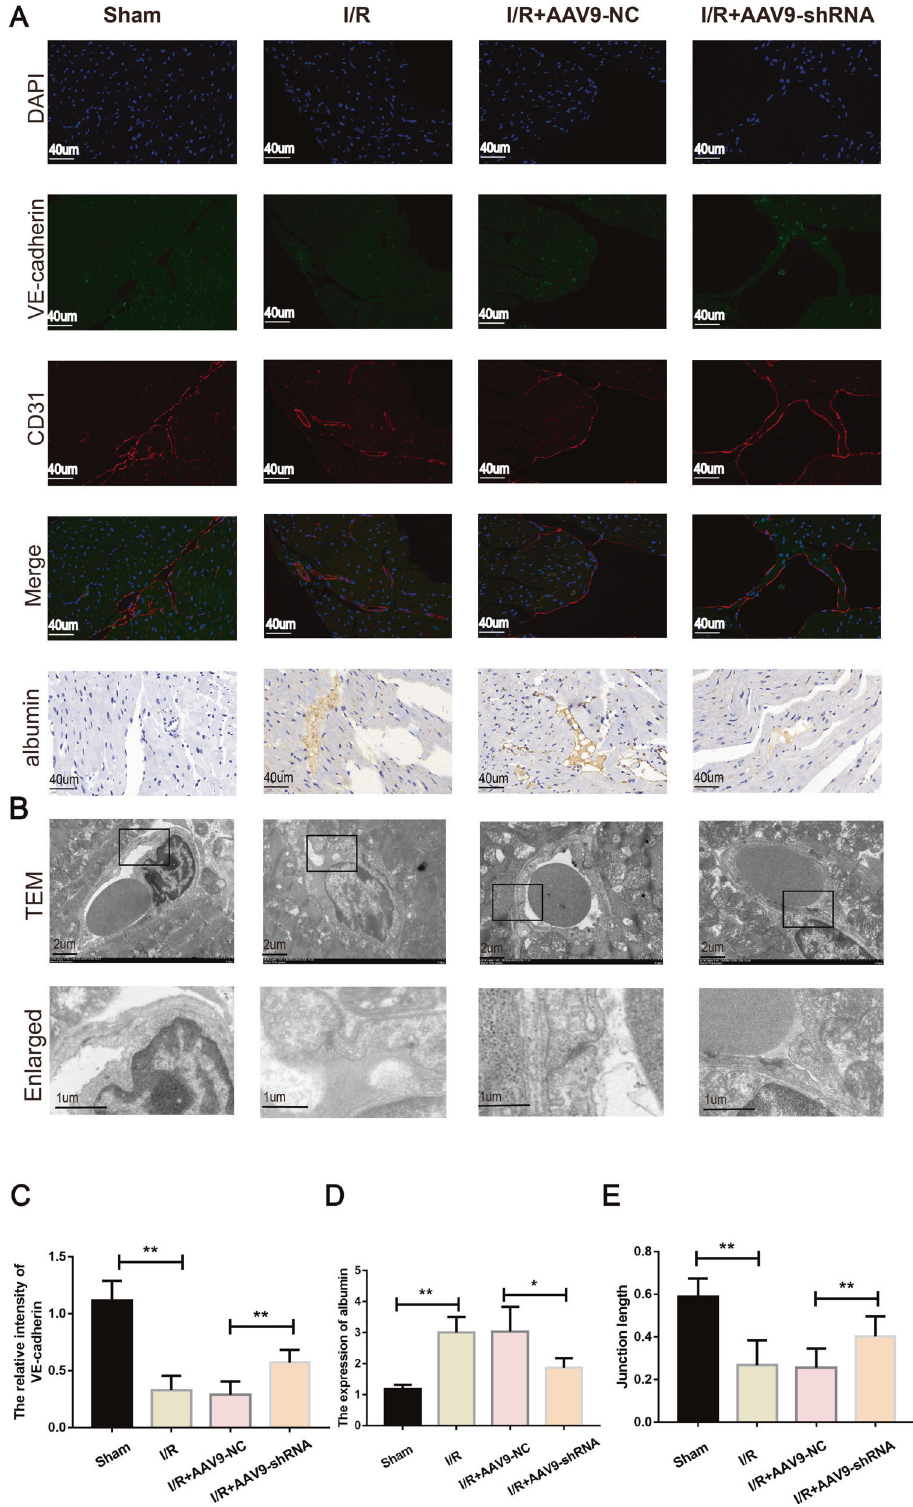
Fig. 6 mmu_circ_0000021 suppression maintained the microvascular barrier following I/R. A , C Endothelial barrier integrity was assessed using double immuno fl uorescence labeling of VE-cadherin and CD31. The discontinuity in VE-cadherin expression was ameliorated by knockdown of mmu_circ_0000021. A , D Immunohistochemistry was used to determine microvascular permeability and plasma albumin levels. Absorbed plasma albumin from the microvessels during I/R was reduced by inhibiting mmu_circ_0000021. B , E Microvessel endothelial cell junction were visualized using TEM. Cellular contact and electron dense region are shown in the lower panels, which are from larger images shown in the top panels (cortical protein complex). * P < 0.05, ** P < 0.01. vs. indicated group; n = 8/group.